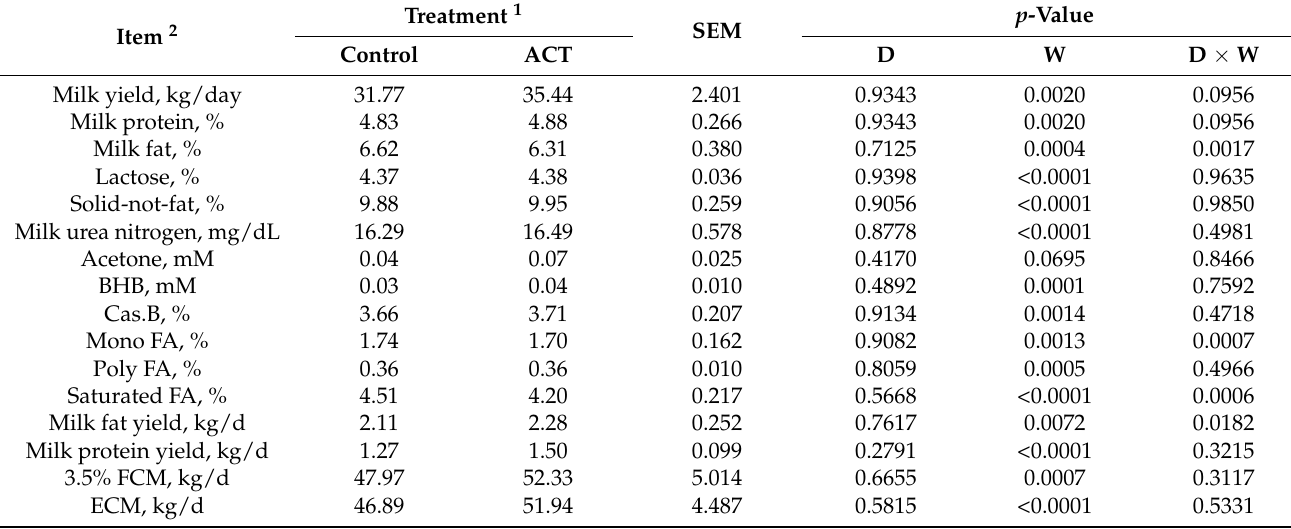
Table 4. Impact of ACT on average milk yield and composition during 8-week treatment of dry cows postpartum. Item 2